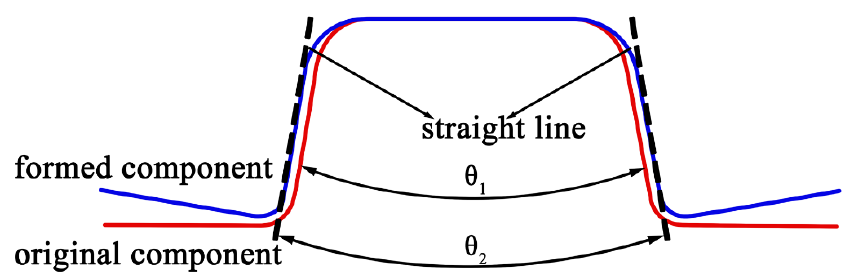
Figure 4. The schematic of the springback angle